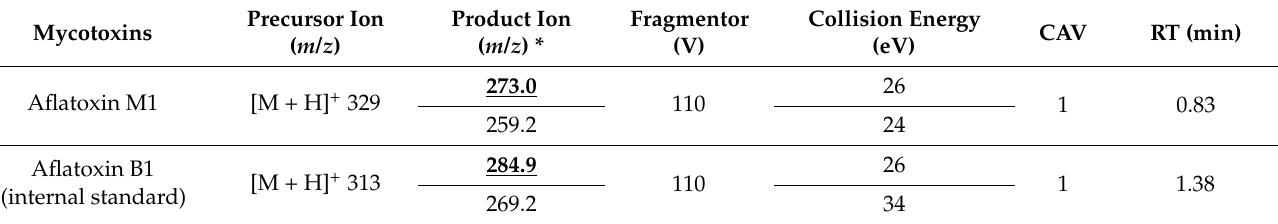
Table 1. MS/MS conditions for MRM